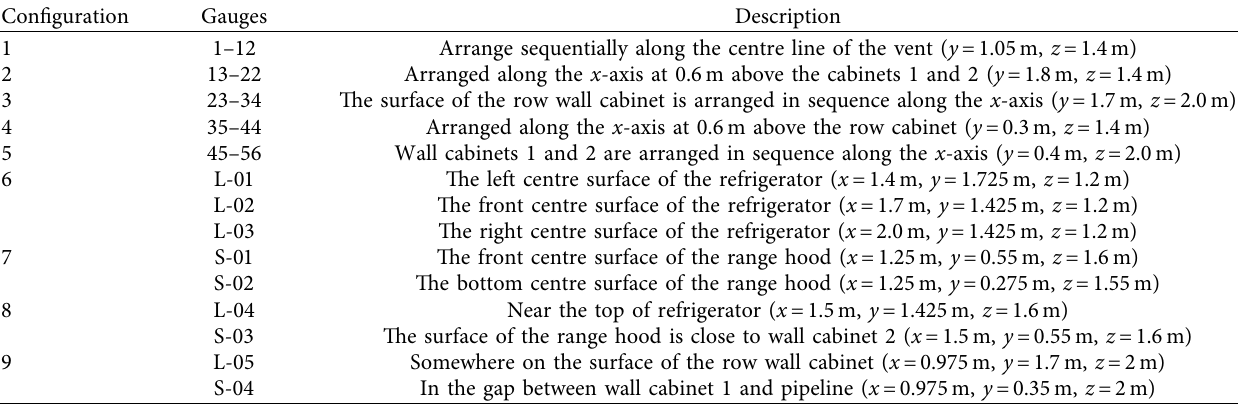
Table 4: The detailed description of measuring